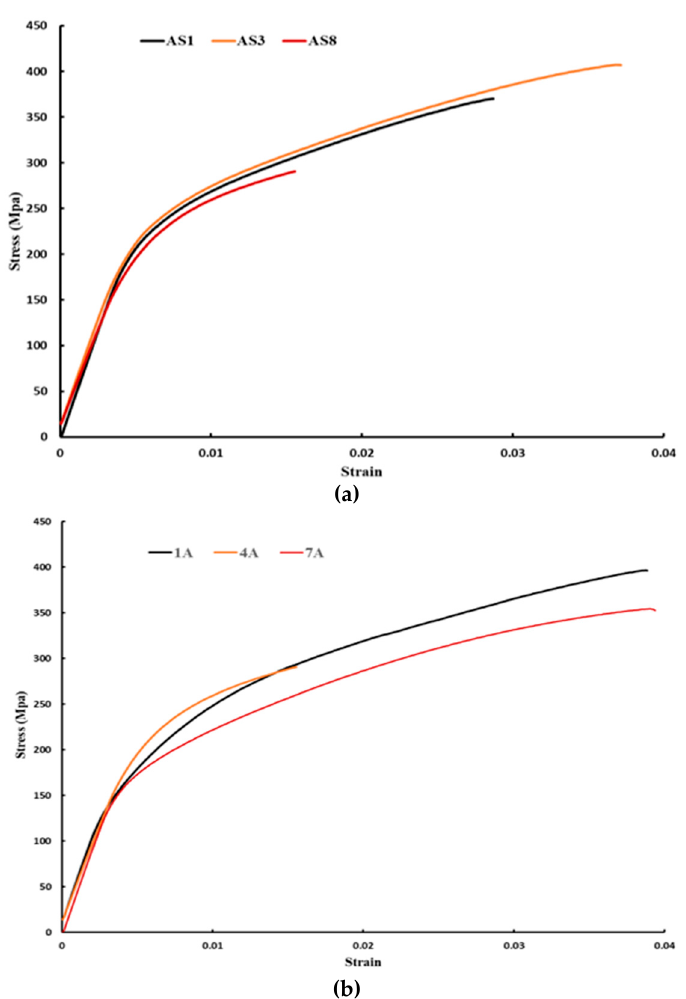
Figure 18. The stress strain diagram for the as-built samples: ( a ) AlSi10Mg; and ( b ) Al6061 samples.